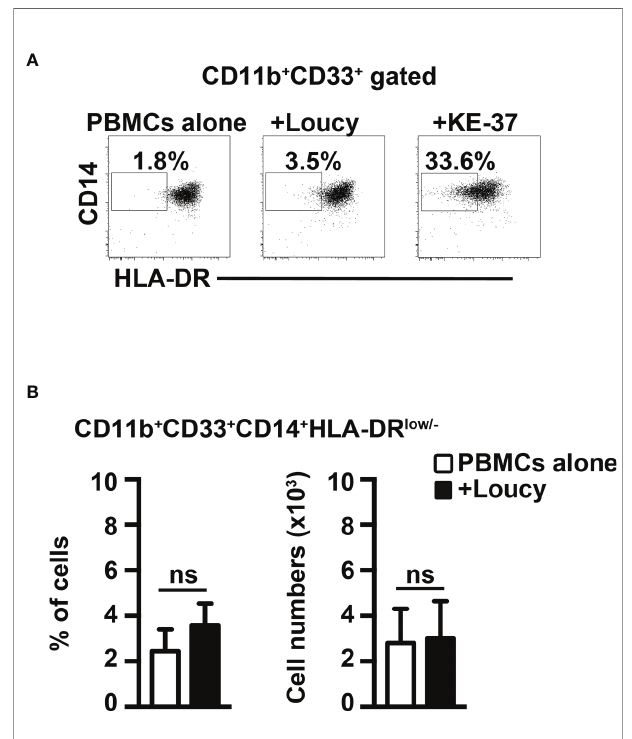
FIGURE 8 | The Notch-inactive T-ALL cell line, Loucy, does not induce MDSCs from healthy PBMCs. (A) Representative dot plot of CD14 + HLA- DR low/neg cells inside CD11b + CD33 + subset, as measured by FACS analysis in harvested PBMCs/Loucy coculture samples (+Loucy), vs. samples of autologous PBMCs cultured alone (PBMCs alone). PBMCs/KE-37 coculture samples (+KE-37) were also included as positive controls of MDSC induction. Numbers inside cytograms indicate the percentages of CD11b + CD33 + CD14 + HLA-DR low/neg cells. (B) Percentages (left panel) and absolute numbers (right panel) of CD11b + CD33 + CD14 + HLA-DR low/neg cells, as measured by the same FACS analysis, as in (A) . In (B) , the values represent the mean ± SD from three independent experiments ( n = 4 samples per group, donors n = 4), each in duplicates. ns, not signi fi